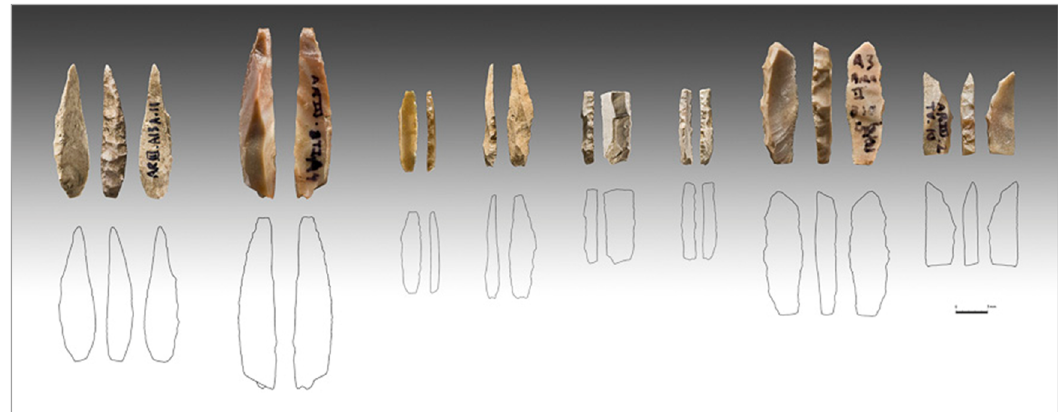
Figure 10: Areeiro 3: backed bladelets made from burin spalls. Photo, J. P. Ruas.